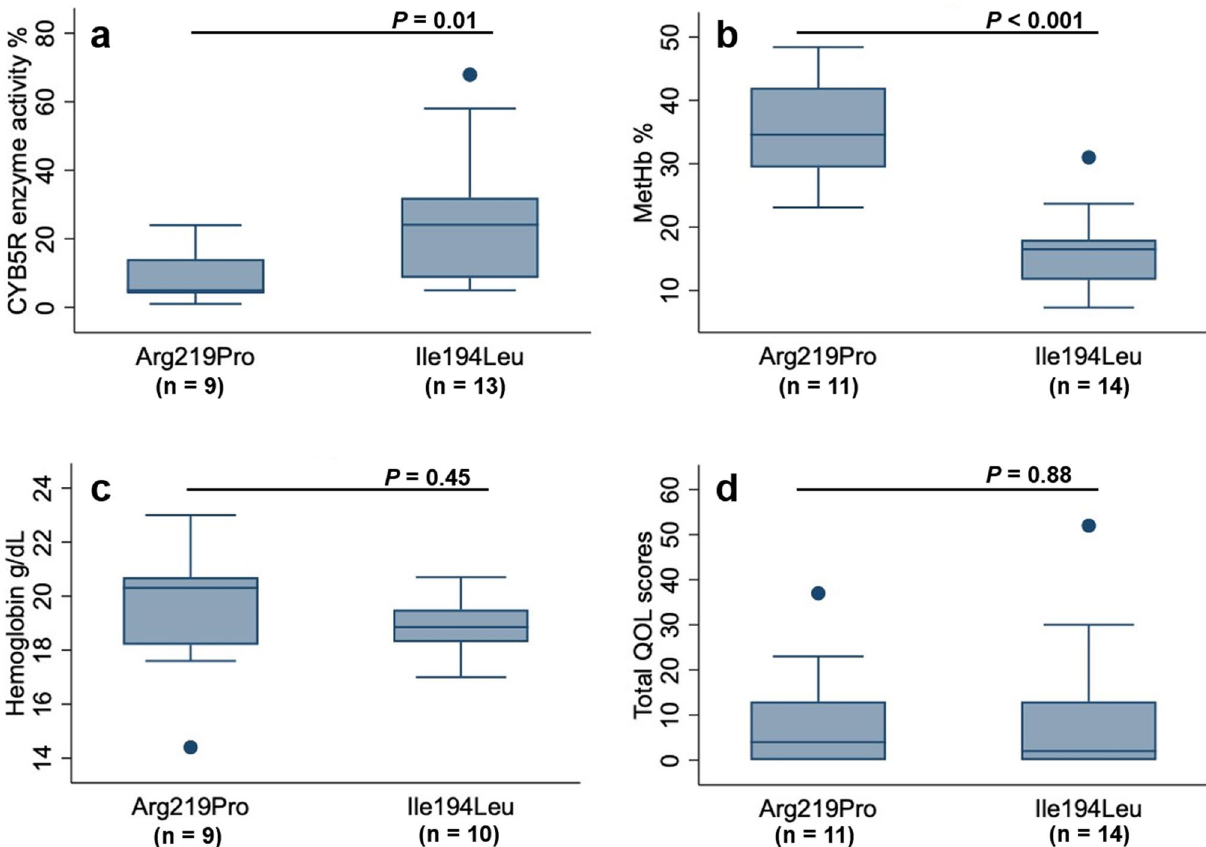
Figure 3. Comparison of hematological, biochemical, and quality of life (QOL) parameters for 24 dogs homozygous for Arg219Pro or the Ile194Leu CYB5R3 gene variants. Box plots comparing (a) erythrocyte cytochrome b 5 reductase (CYB5R) enzyme activity, (b) methemoglobin (MetHb) concentrations, (c) hemoglobin concentrations and, (d) overall total QOL scores (i.e. sum of total scores for all 12 questions). The horizontal line is at the median, the boxes span from the 25th to 75th percentile, and whiskers extend from each quartile to minimum or maximum. The closed circles represent data points beyond 1.5 × interquartile range.